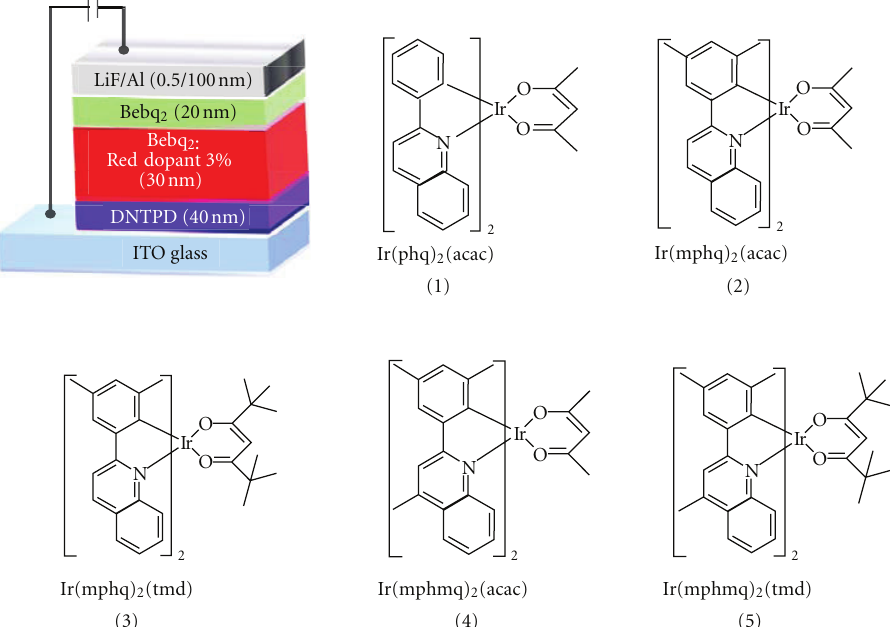
Figure 14: Schematic cross-section of red PHOLED with di ff erent complexes 1–5 and molecular structure of complexes 1–5.